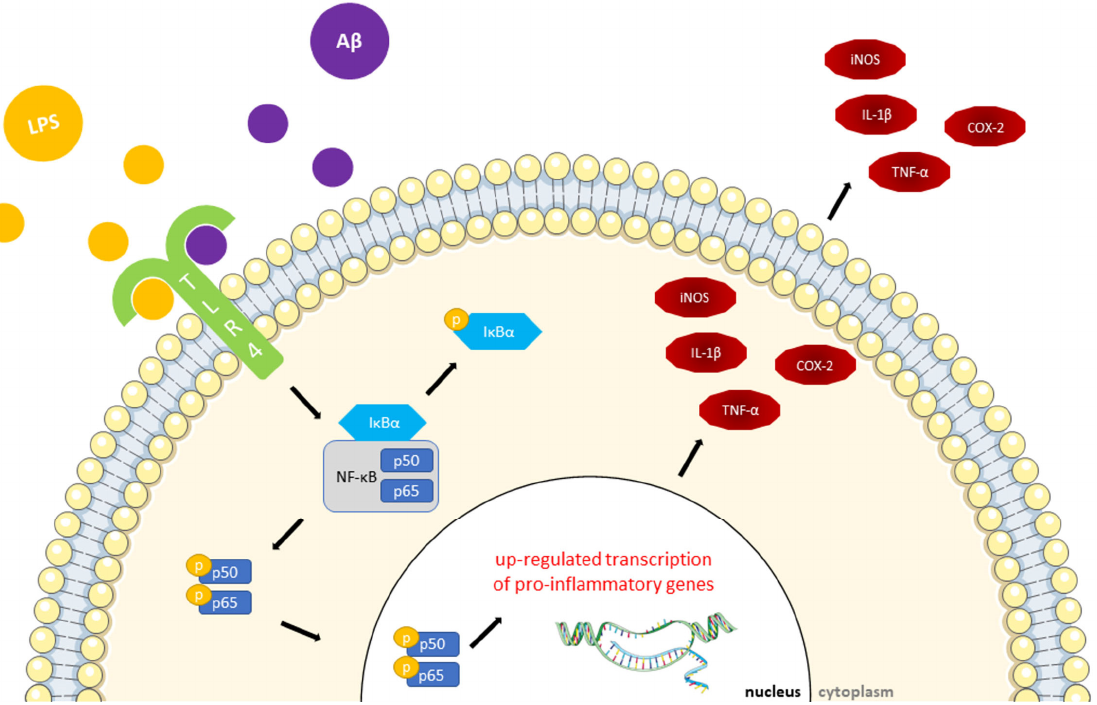
Figure 1. Schematic representation of the LPS-induced inflammatory mechanism mediated by the NF- κ B pathway. TLR4 senses LPS and A β and triggers the activation of NF- κ B. Phosphorylated I κ B α permits the NF- κ B subunits p50-p65 to translocate into the nucleus, up-regulating the transcription of pro-inflammatory genes and provoking the release of several inflammatory mediators, such as iNOS, COX-2, IL-1 β and TNF- α . Parts of the figure were drawn by using pictures from Servier Medical Art. Servier Medical Art by Servier is licensed under a Creative Commons Attribution 3.0 Unported License (https://creativecommons.org/licenses/by/3.0/ accessed on 20 February 2023).